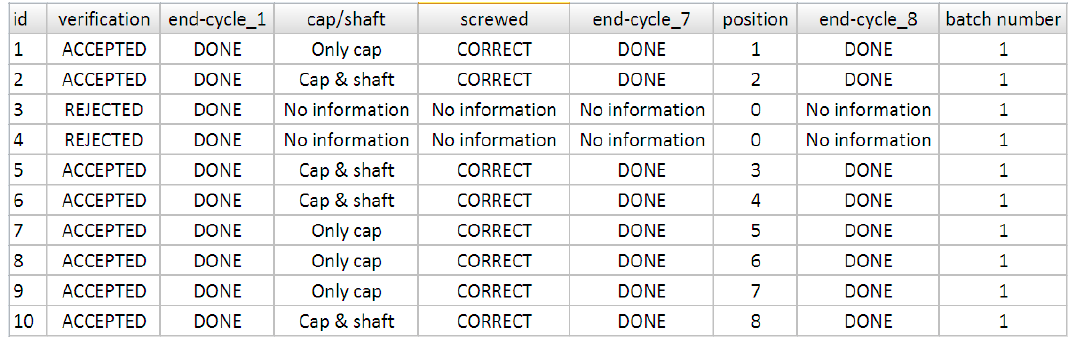
Figure 20. Table of the file obtained with VB scripts and SQL statements.